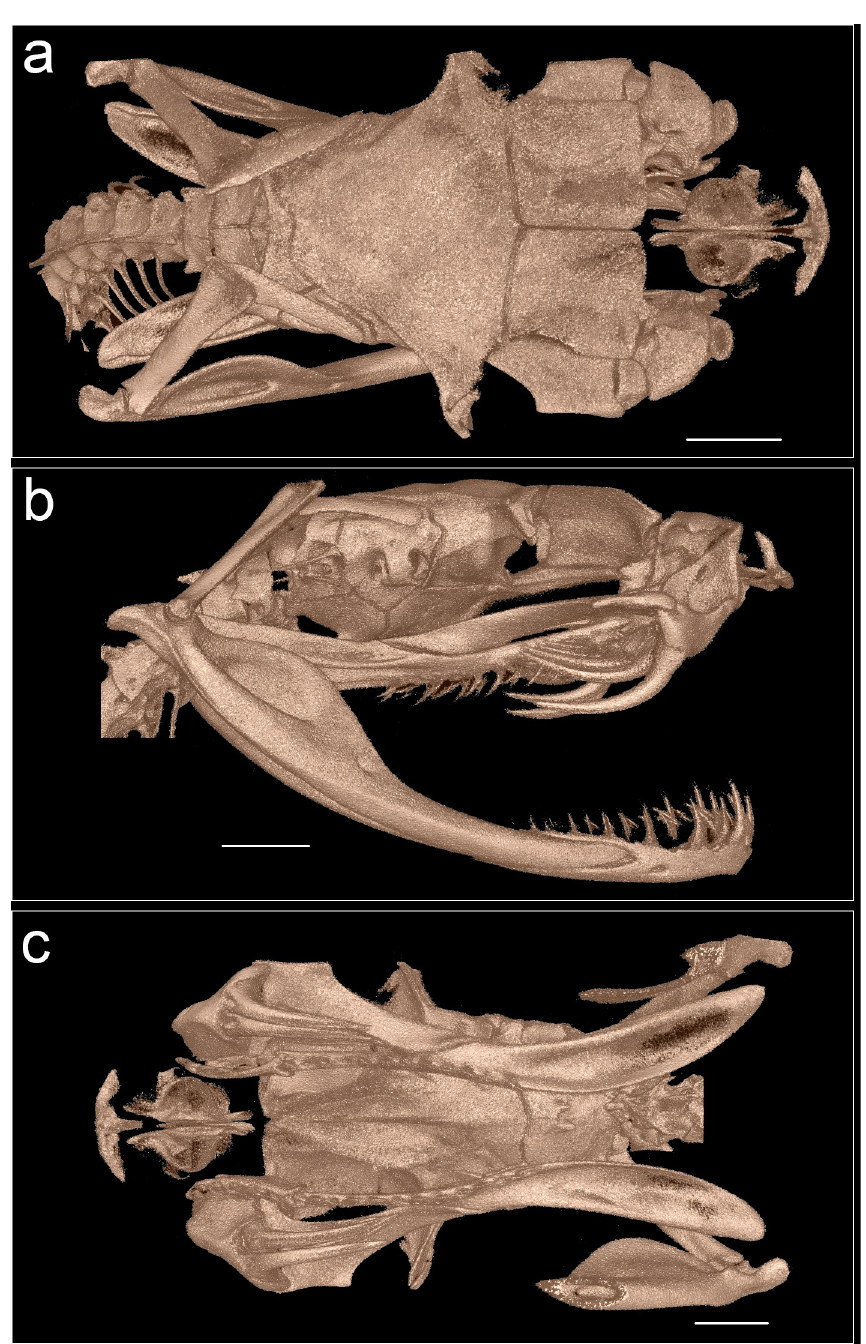
Fig 5. MicroCT images of the skull of male paratype BNHS 3660, (a) dorsal view, (b) lateral right view, (c) ventral view (dentary removed for visualizing the ventral aspect of the brain case). subgenera Viridovipera by having rust coloured eye in males versus bright red or amber (rarely yellow) coloured in T . stejnegeri Schmidt, yellow or yellowish green in T . vogeli David, Vidal & Pauwels,green or yellowish green in T . medoensis Zhao, and bright or deep red in T . yunnanen- sis , and a green coloured eye in females versus yellow or amber in T . stejnegeri , yellow in T .